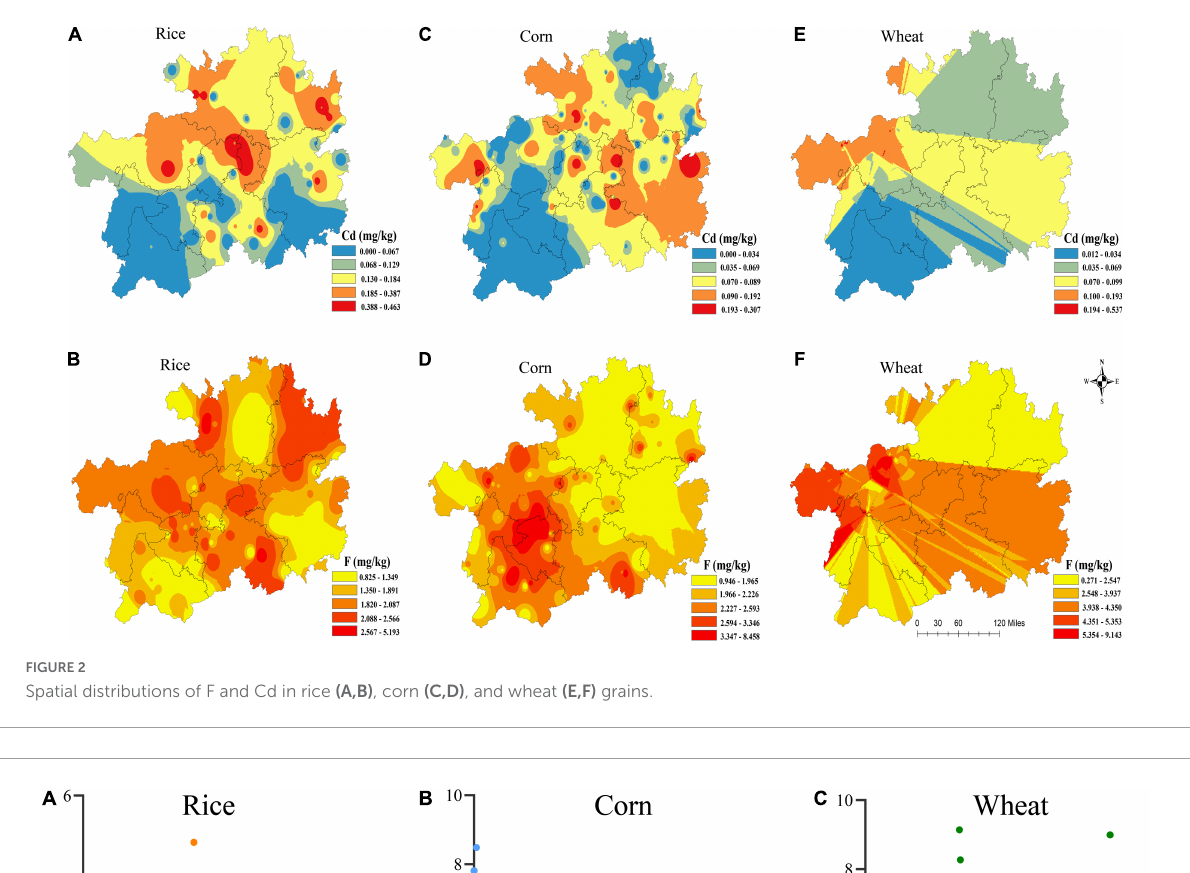
FIGURE2 Spatial distributions of F and Cd in rice (A,B) , corn (C,D) , and wheat (E,F) grains.